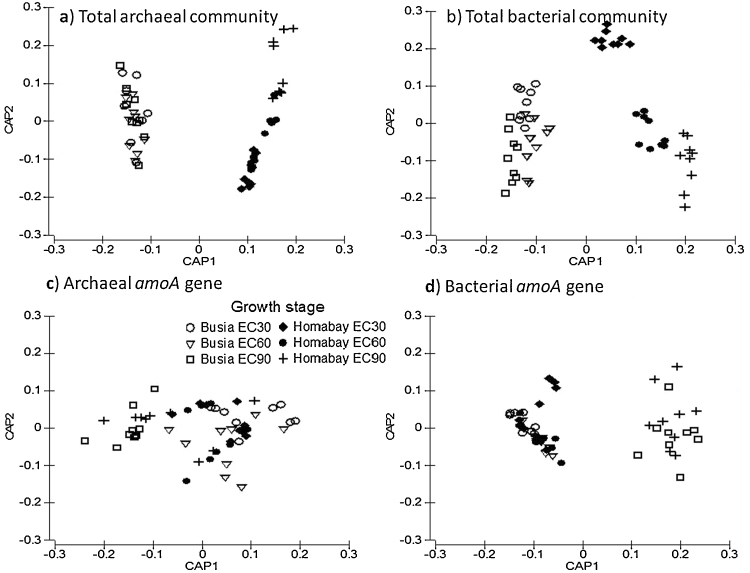
Canonical analysis of principal coordinates (CAP) for visual presentation of prokaryotic community composition (TRLFP) as shaped by “Site” and “Growth stage”. Prokayotic communities are (a) total archaea, (b) total bacteria, (c) ammonia-oxidizing archaea and (d) ammonia-oxidizing bacteria.